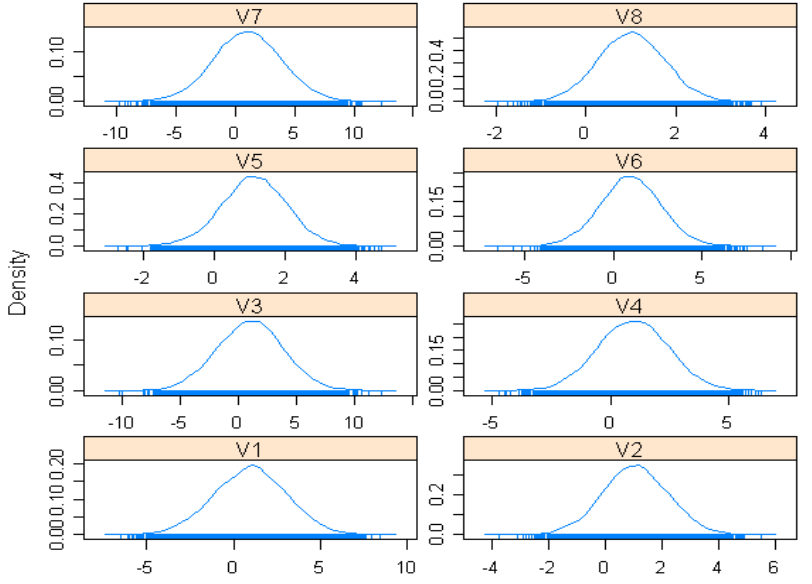
Figure 7. Density plots of β 0 , . . . , β 7 for the HBLD model.